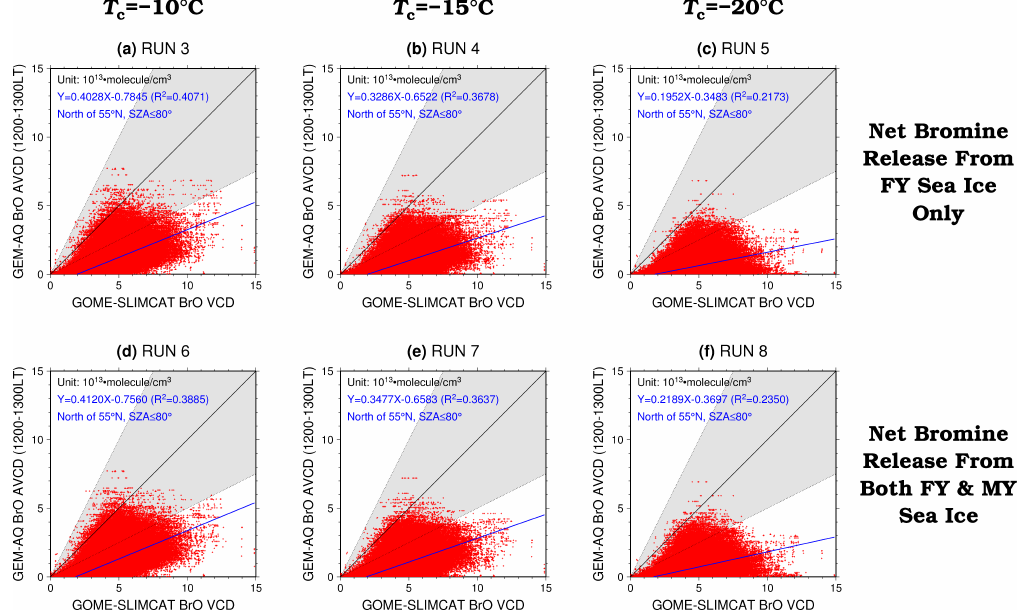
Fig. 10. Scatter plots of GEM-AQ BrO AVCDs versus GOME-SLIMCAT tropospheric BrO VCDs to the north of 55 ◦ N and for SZA ≤ 80 ◦ during 1–30 April 2001. The GEM-AQ output (at the resolution of 0.88 ◦ × 0.88 ◦ in the Arctic core) is regridded to 0.5 ◦ × 0.5 ◦ used for the GOME-SLIMCAT dataset: (a) Run 3, (b) Run 4, (c) Run 5, (d) Run 6, (e) Run 7, and (f) Run